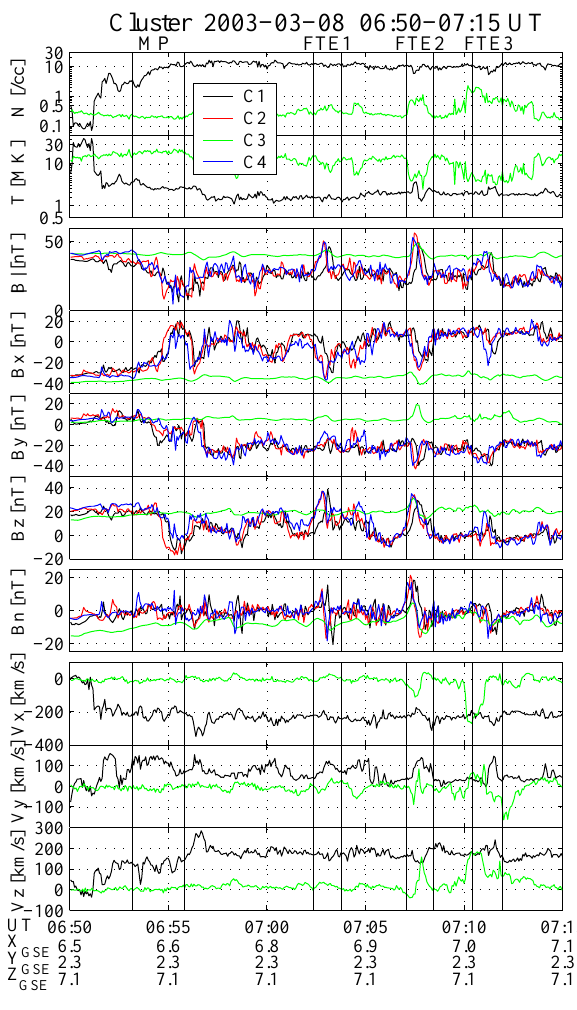
Fig. 1. Cluster data on 8 March 2003, 06:50–07:15 UT. The pan- els, from top to bottom, show: number density, ion temperature, magnitude and GSE components of the magnetic field, field com- ponent normal to the magnetopause, and GSE velocity components. The GSE location of Cluster was approximately (6.9, 2.3, 7.1) R E . Time interval between the first pair of vertical lines was used for determining the normal to the magnetopause from the minimum variance analysis of the magnetic field (MVAB) measured by the Cluster 1 spacecraft (C1). The following three intervals, each in- cluding one flux transfer event, were used for the